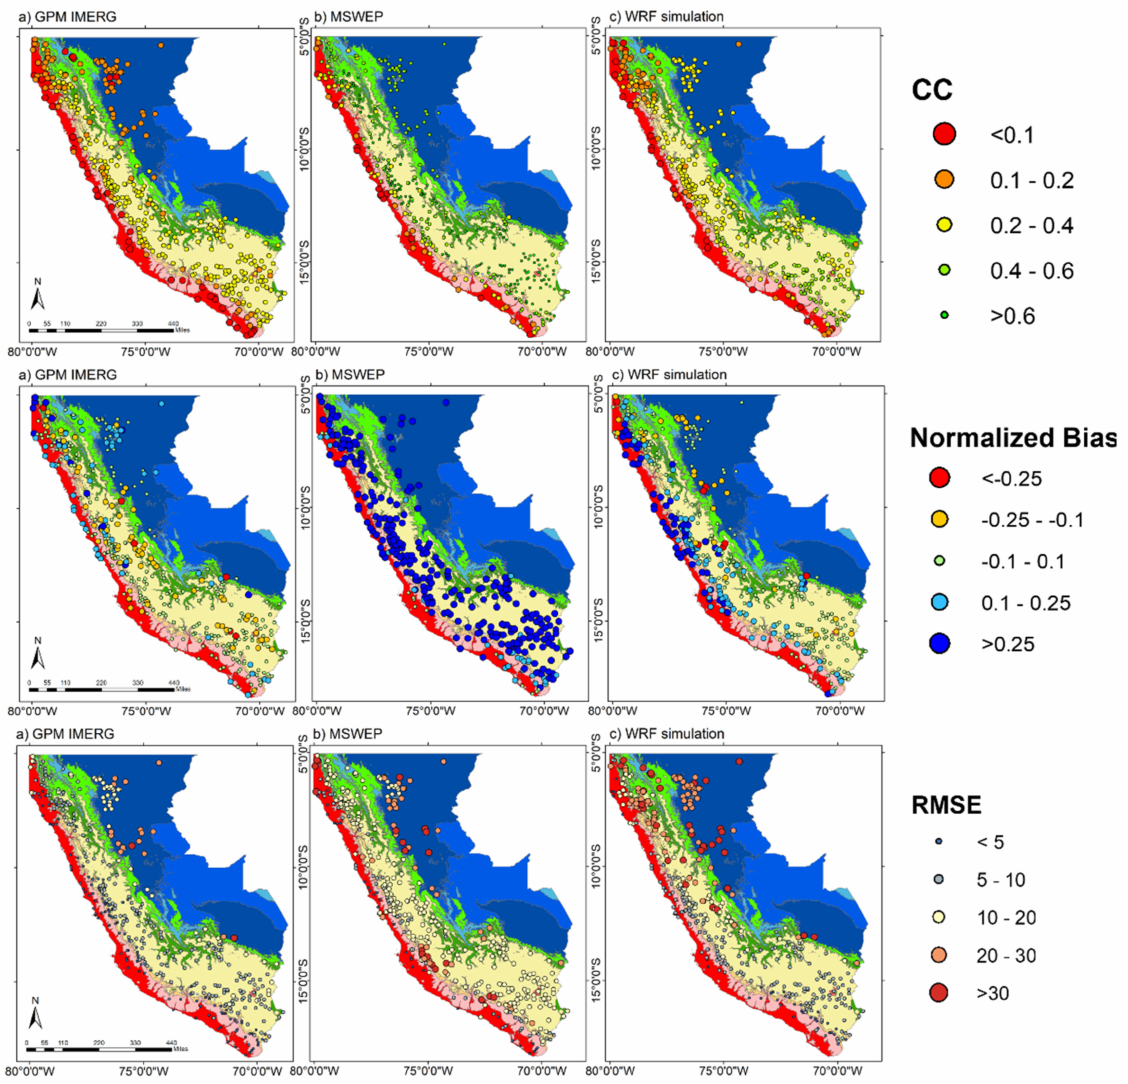
Figure 4. The map of daily precipitation statistical comparison of ( a ) GPM IMERG, ( b ) MSWEP, and ( c ) WRF simulation with rain gauge data from January 2010 to July 2018 in the Peruvian